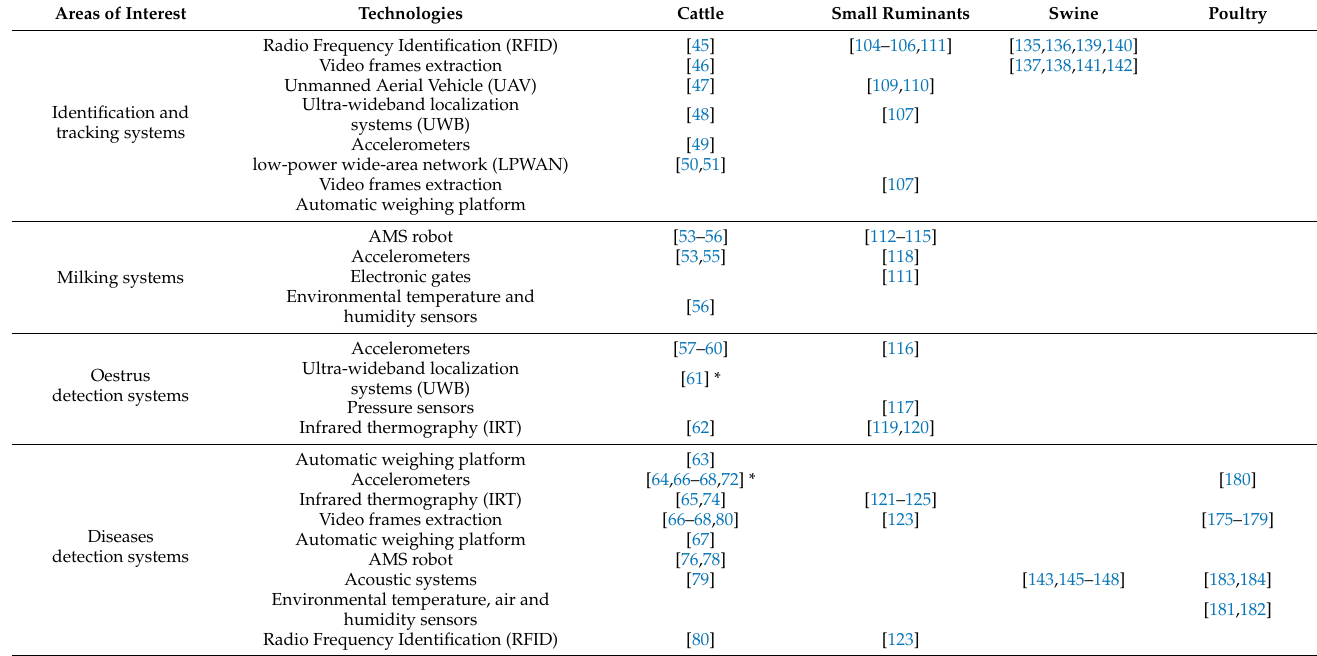
Table 1. Summary of technologies used in PLF to monitor different parameters in various animal species. References that use IoT approach are marked with an asterisk